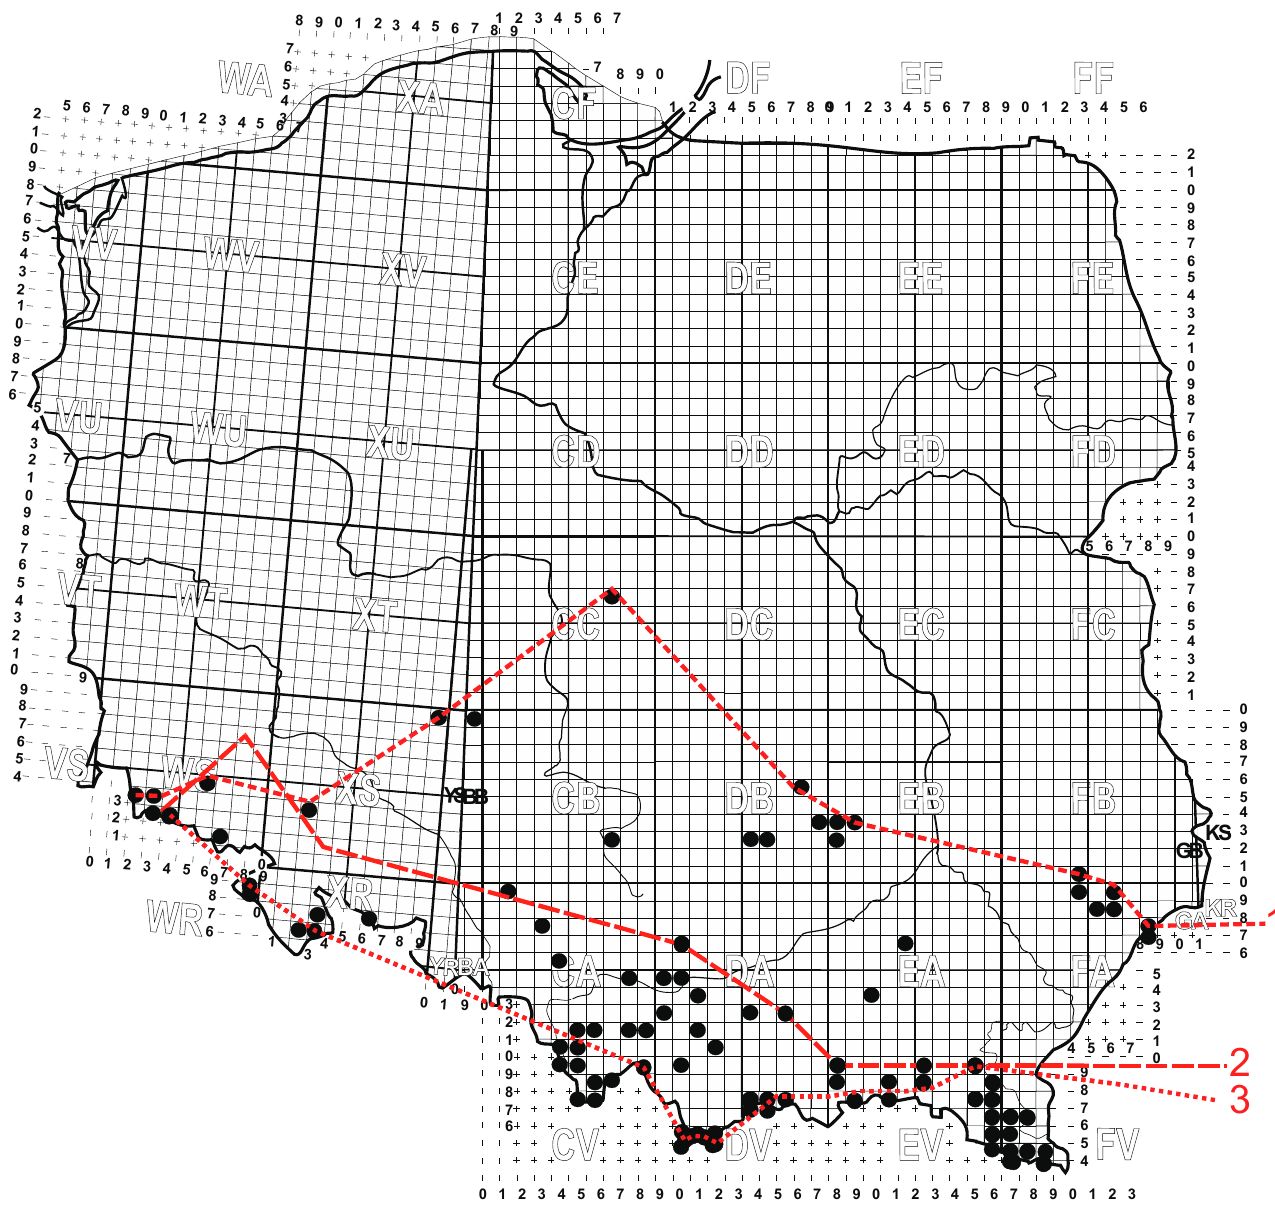
Figure 3. Geographical distribution of species from the genus Trachytes which have their northern range of occurrence in Poland: 1— Trachytes irenae , 2— Trachytes minima , 3— Trachytes montana .